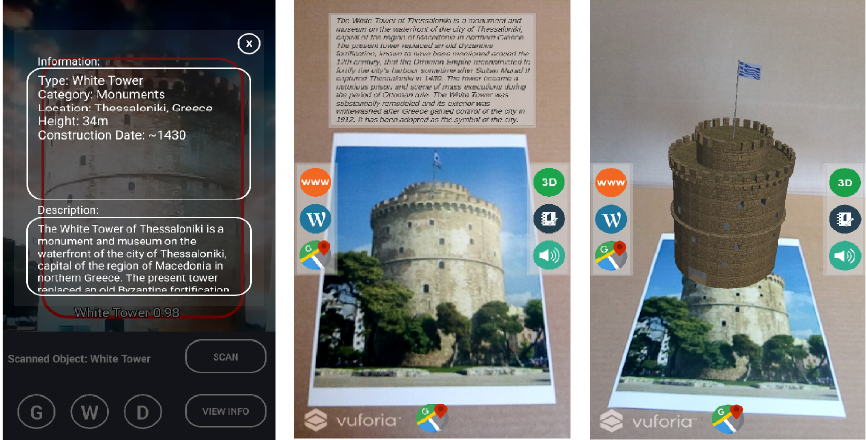
Fig. 1. Examples of the augmented reality